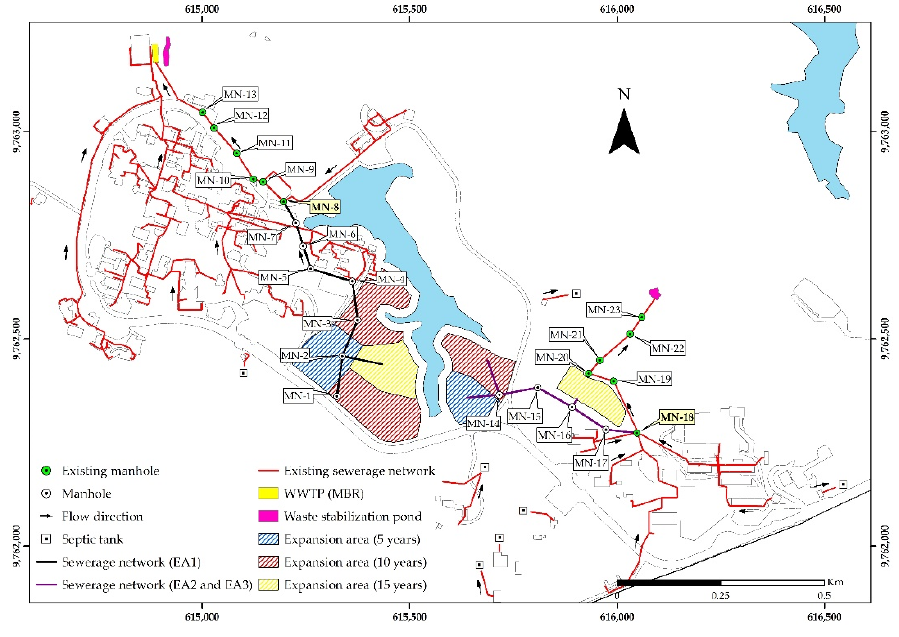
Figure 12. Sewerage networks for expansion zones 1, 2, and 3.